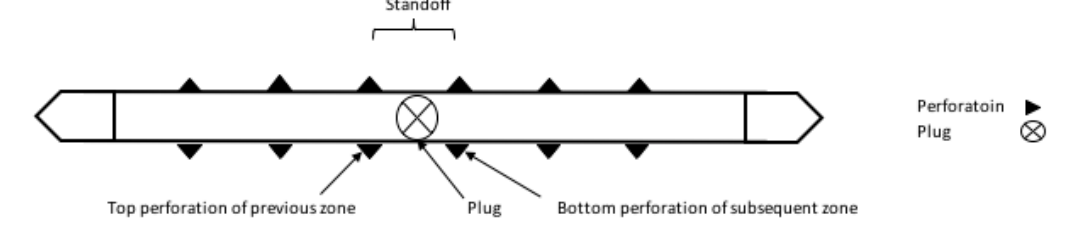
Figure 8. Perforation standoff between the top perforation of the previous stage and the bottom perforation of the subsequent stage [18].